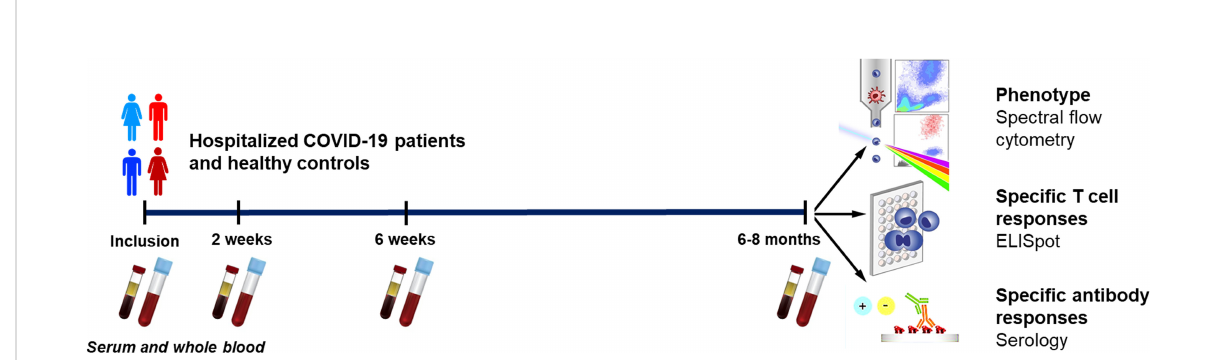
FIGURE 1 Graphical outline of the study. Peripheral blood was collected from patients with COVID-19 that needed hospitalization (N=46) and healthy controls (N=31). Clinical parameters were measured at enrollment, and the levels and effects on peripheral immune cells and neutralizing antibodies were assessed at enrollment, 2 weeks, 6 weeks, and 6-8 months. The phenotype of the T cells and B cells were analyzed by fl ow cytometry, SARS-CoV-2-speci fi c T cells by ELISPOT, and SARS-CoV-2-speci fi c antibodies by serological